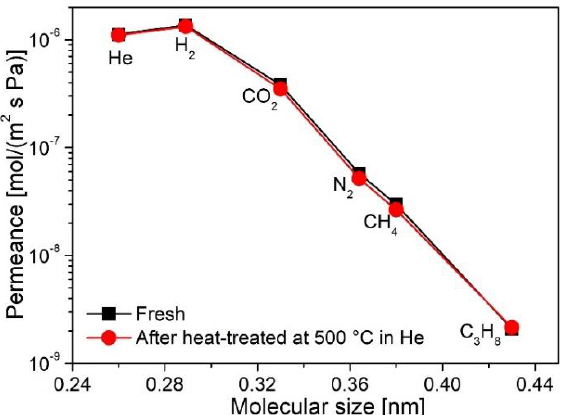
Figure 24. Single-gas permeance at 200 °C as a function of molecular size for a PCS-derived mem- brane before and after thermal stability testing at 500 °C under a He atmosphere for 12 h. Adapted from [72] with permission from Elsevier. with permission from